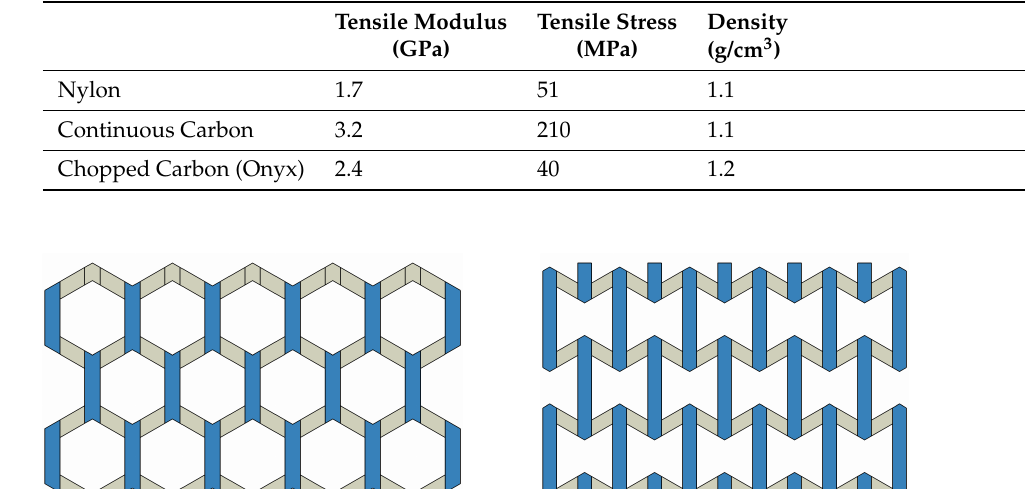
Table 1. Mechanical properties of nylon, continuous carbon-fibre-reinforced nylon, and chopped carbon-fibre-reinforced nylon.